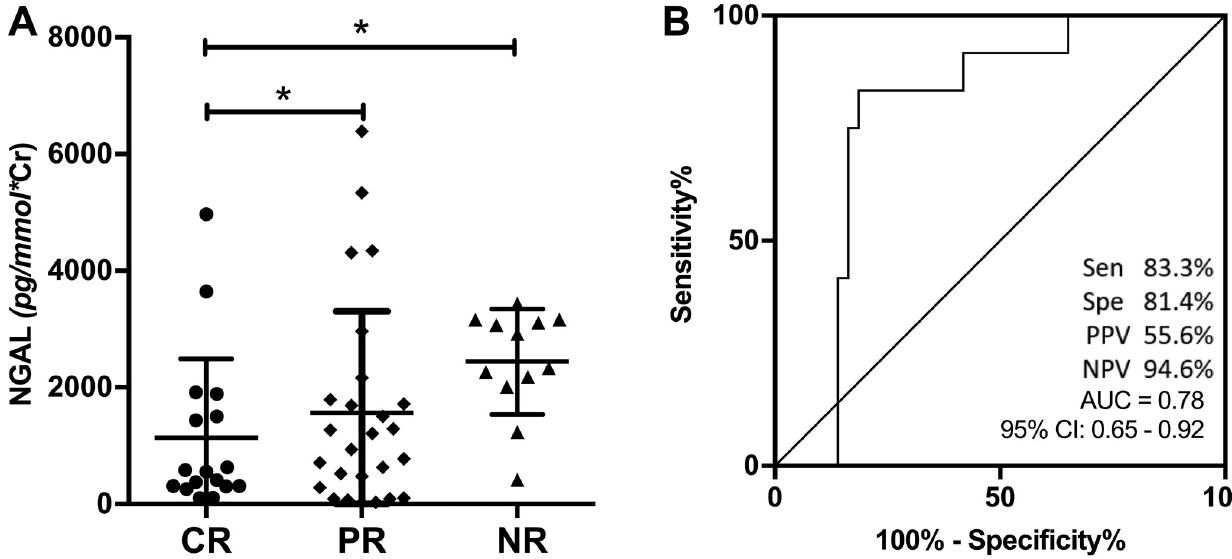
Fig 3. NGAL as a potential marker of treatment response. Comparison of NGAL in LN patients with different response status after 6 months of treatment (A) and ROC curve for NGAL to differentiate responders from non-responders (B). NGAL: neutrophil gelatinase-associated lipocalin, CR: complete response, PR: partial response, NR: Non- response, Sen: sensitivity, Spe: specificity, PPV: positive predictive value, NPV: negative predictive value, AUC: area under the curve.